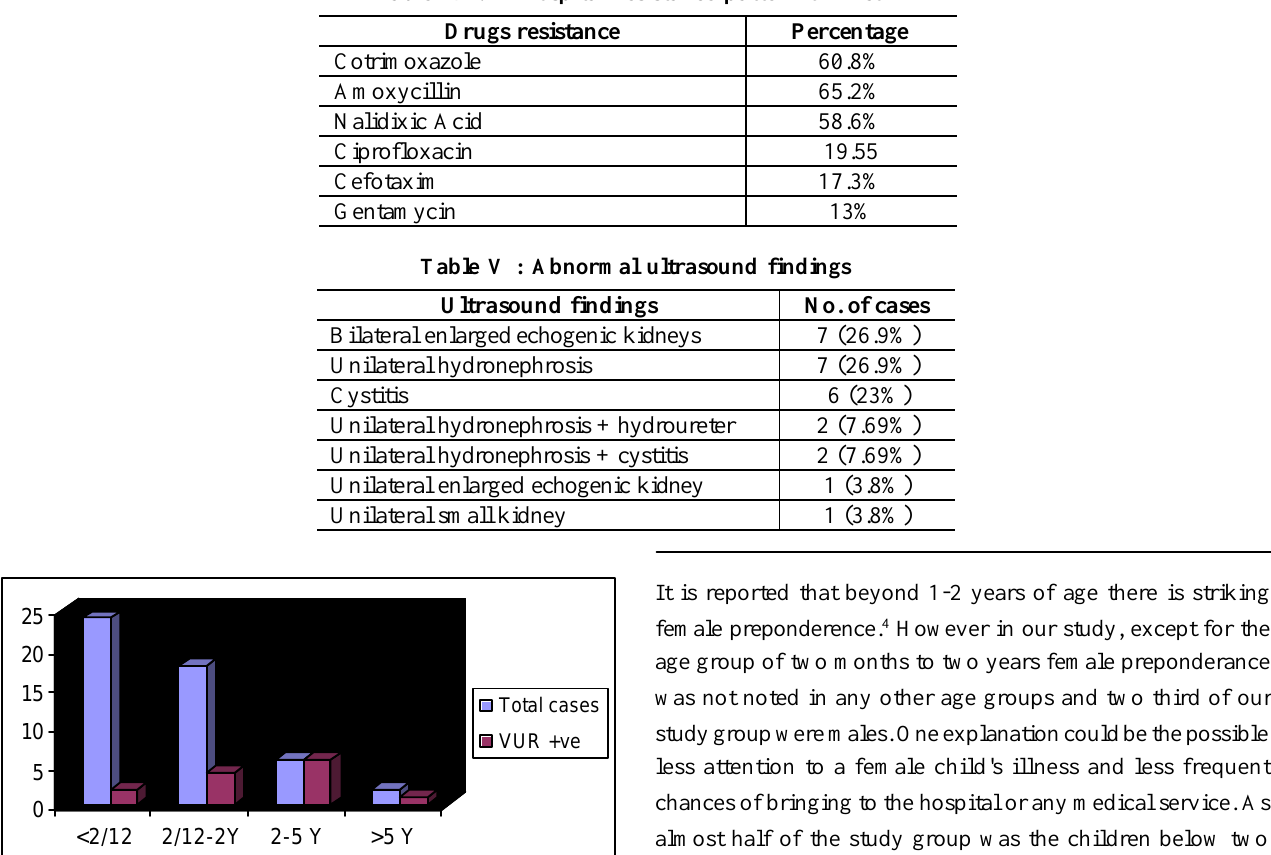
Table IV : In-hospital resistance pattern of E coli